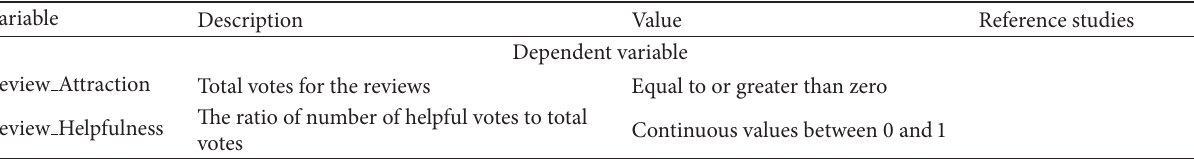
Table 2: List of variables.